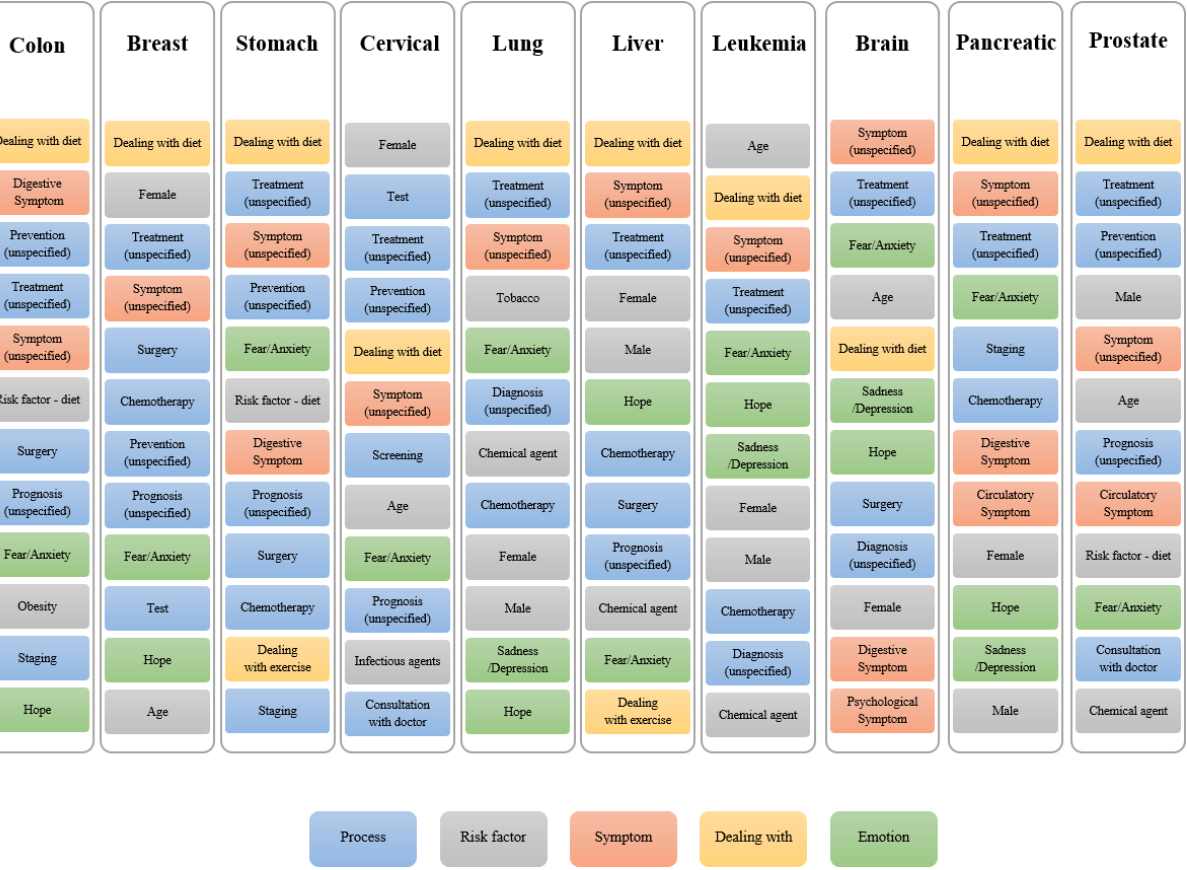
Figure 8. Top ranked end-node class concepts by cancer